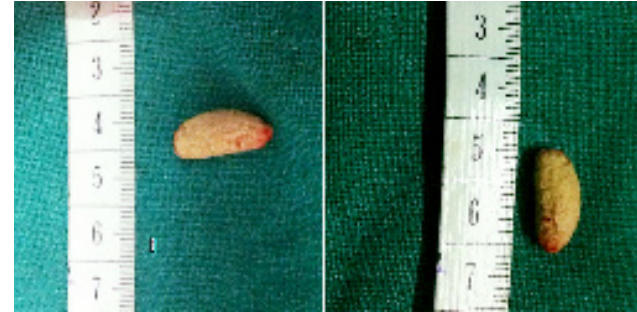
Fig 3 : Picture showing size of the calculus removed from left submandibular